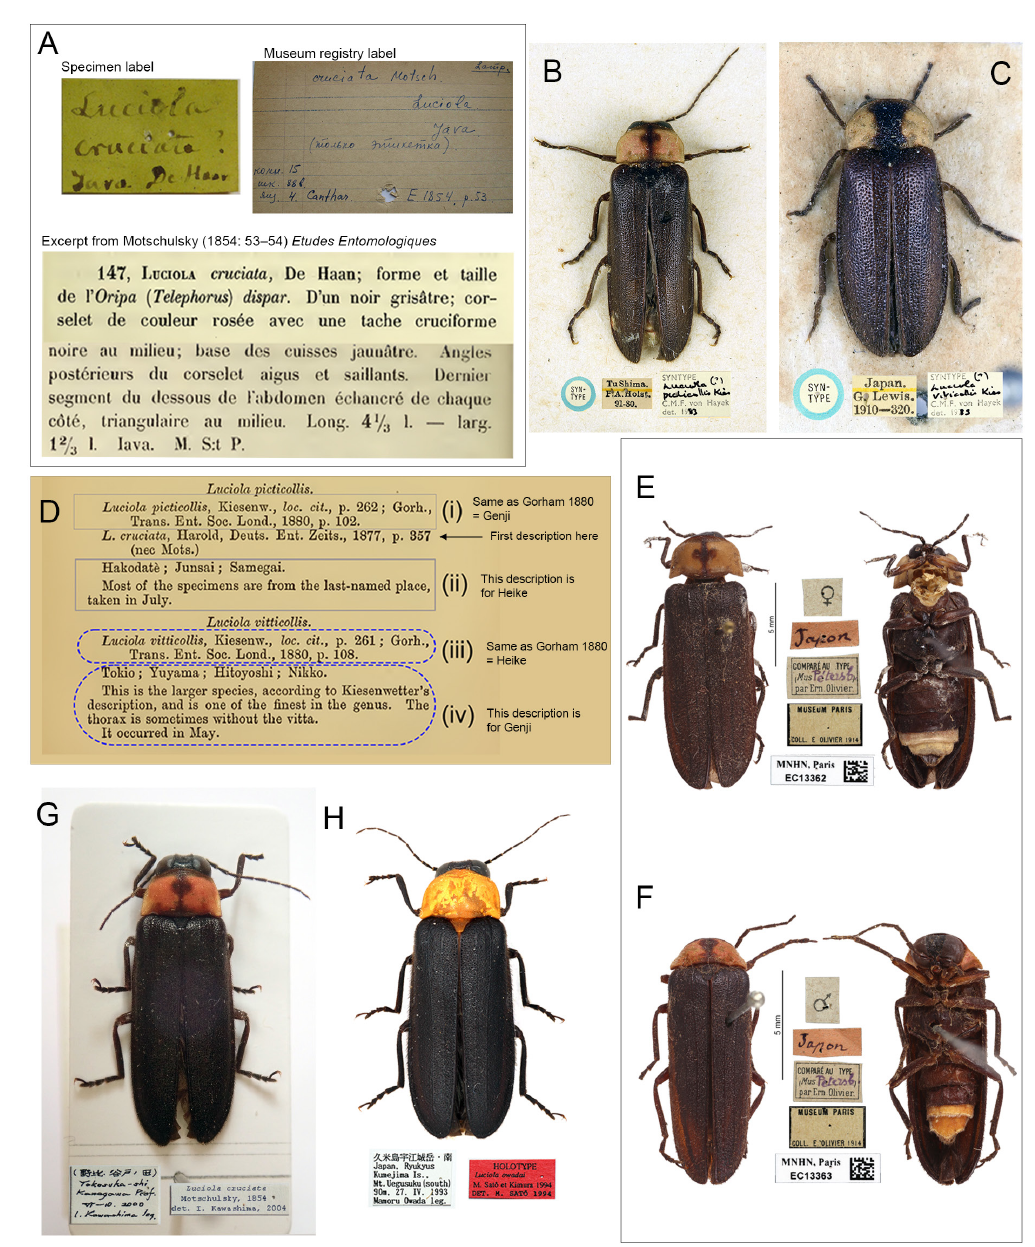
Fig. 2. Background information. A . Type specimen label, museum registry label, and excerpt of original description of Luciola cruciata Motschulsky, 1854 in ZMMU. B . Luciola picticollis Kiesenwetter, 1874, ♂, syntype (NHMUK). C . Luciola vitticollis Kiesenwetter, 1874, ♂, syntype (NHMUK). D . Excerpt from Gorham (1883) annotated by H. Suzuki and I. Kawashima. E–F . Dorsal (left) and ventral aspects specimens of Luciola cruciata from E. Olivier collection in MNHN compared with types. G . Nipponoluciola cruciata (Motschulsky, 1854) gen. et comb. nov., neotype (KPMNH). H . Luciola owadai Satô & Kimura, 1994 holotype (NSMT). Image A specimen label and registry by Aleksey Gusakov (ZMMU); excerpt of original description from Biodiversity Heritage Library; images B–C Luciola picticollis by Keita Matsumoto (NHMUK) https://www.flickr.com/; image D reproduced from Biodiversity Heritage Library; images E–F by Christophe Rivier (MNHN); image G by I. Kawashima; image H by H. Yoshitomi (Entomological Laboratory of Ehime